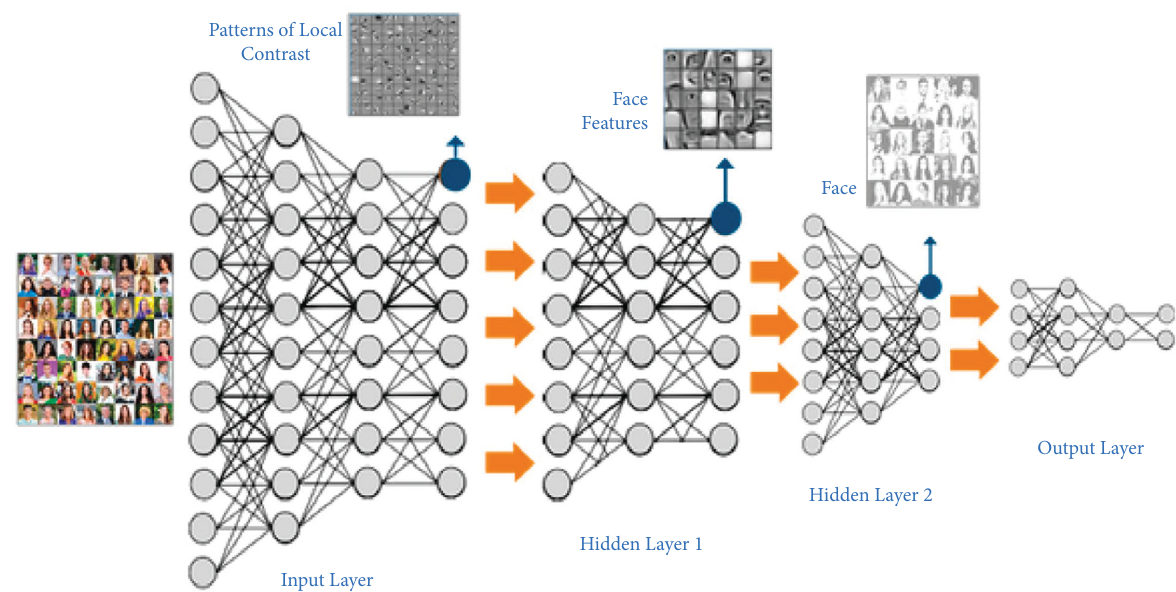
Figure 2: Lung cancer prediction by CNN methods